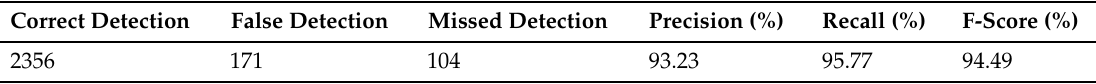
Table 4. Taillight detection results.